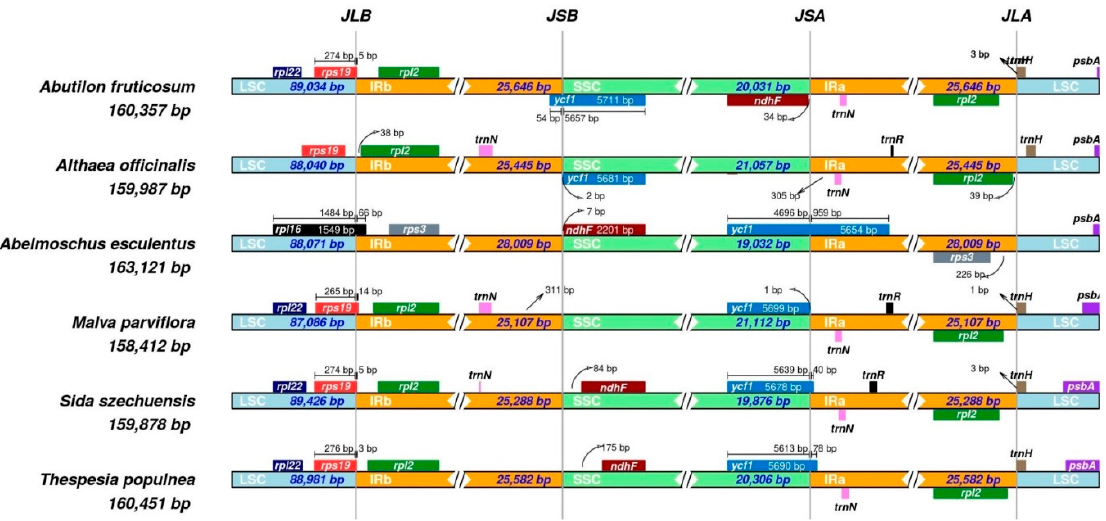
Figure 8. Comparison of the borders of the IR, SSC and LSC regions among six chloroplast genomes of Malvaceae (JLB: juction of LSC and IRB; JSB: junction of SSC and IRB; JSA: juction SSC and IRA; JLA: junction LSC and IRA).